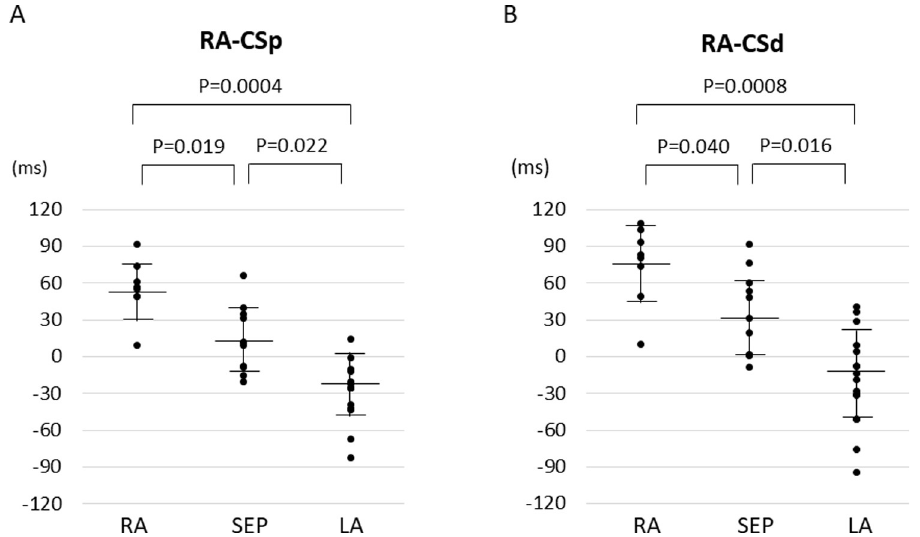
Fig 2. Comparison of intra-atrial activation intervals of non-PV trigger among RA, SEP and LA. RA-CSp, intra- atrial activation interval from the earliest in RA to proximal CS; RA-CSd, intra-atrial activation interval from the earliest in RA to distal CS; RA, right atrium; SEP, atrial septum; LA, left atrium; CS, coronary